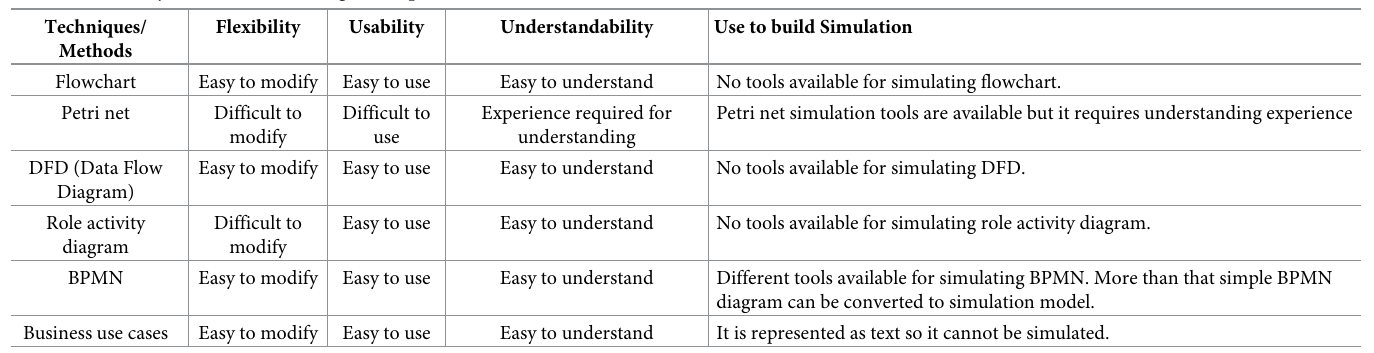
Table 2. Summary of different modeling